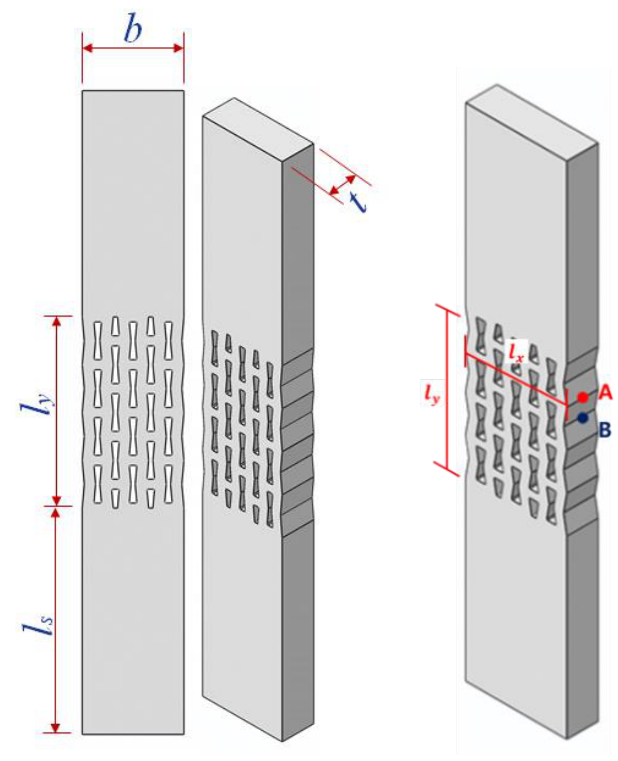
Figure 1. Design parameters of specimens. Table 1. Design parameters of tested specimens.